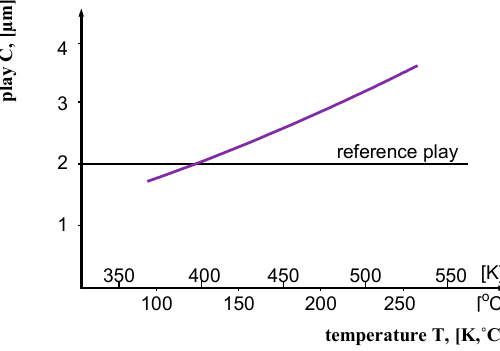
Figure 8. The play in the needle-nozzle holder precision pair of injector 5 as a function of operating temperature.